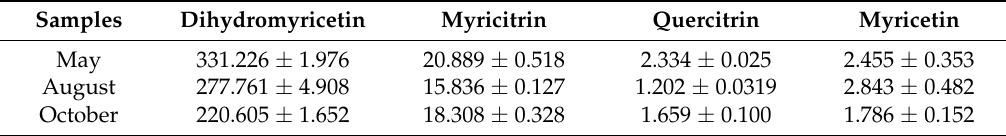
Table 1. The content of active component in Ampelopsis megalophylla (mg/g, χ + D, n = 3).